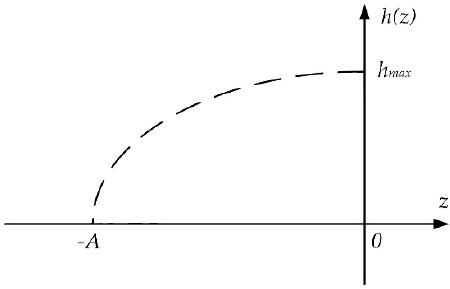
Figure 8. The functional relation between the parameter z and h ( z ) .